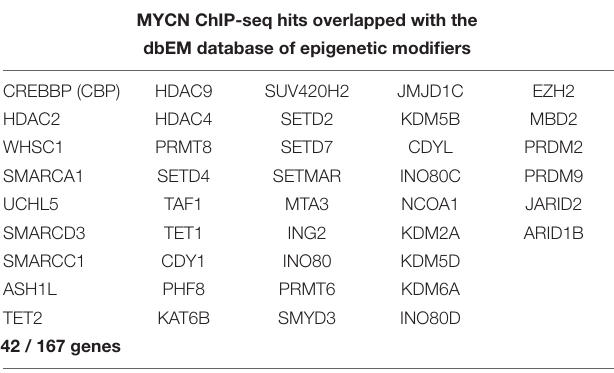
TABLE 1 | Comparison of ChIP-seq MYCN target gene dataset with a curated epigenetic regulators lists. MYCN ChIP-seq hits overlapped with the dbEM database of epigenetic